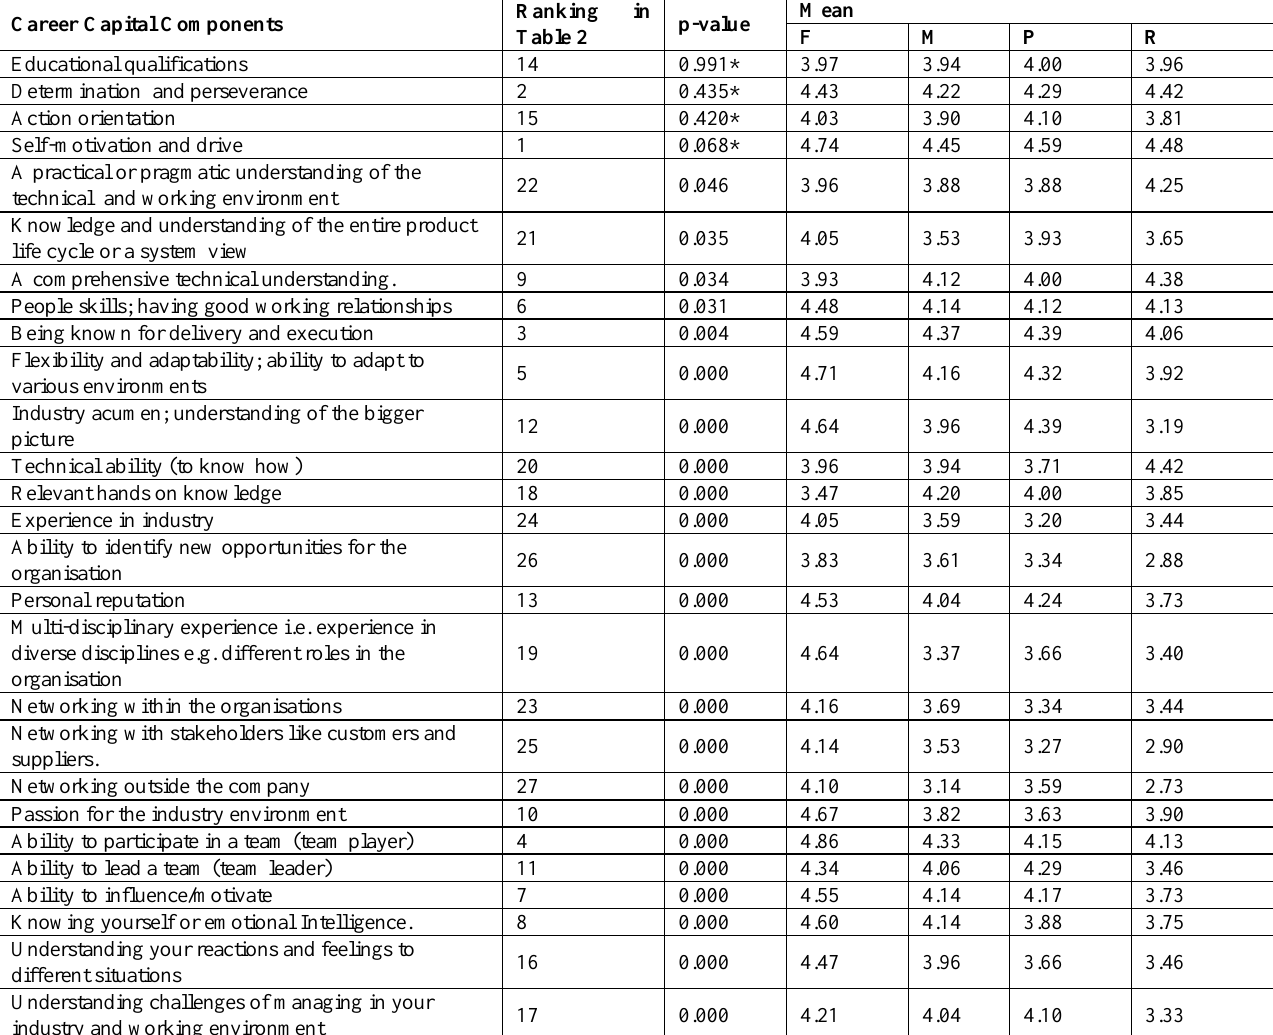
Table 4: Comparison of rankings of career capital components across the 4 sectors Career Capital Components